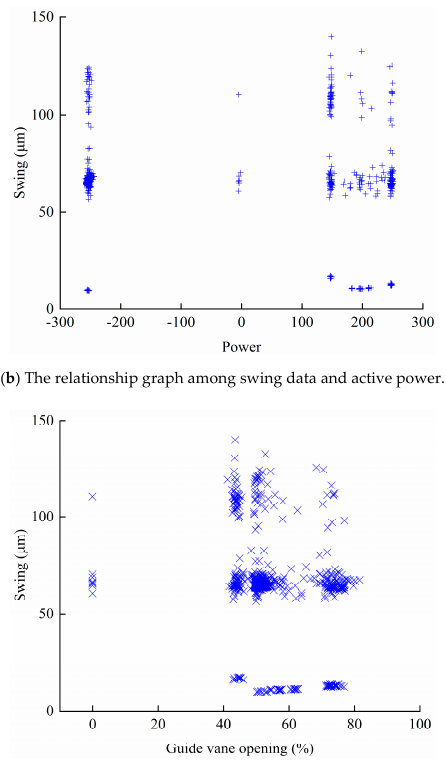
Figure 5. The relationship graph among swing data in Y direction and monitoring data ( H , P , G ): ( a ) working head, ( b ) active power and ( c ) guide vane opening.